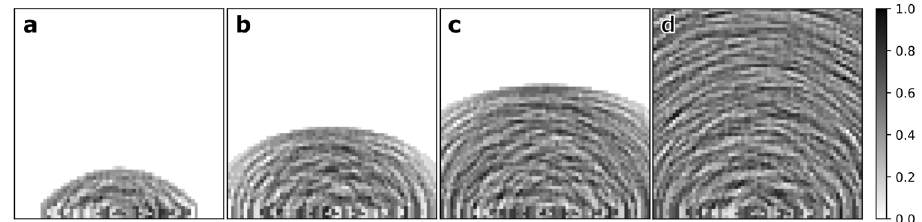
Fig. 2 Time-of- fl ight sampling mask. Panels a , b , c , and d show the normalized spatiotemporal mask at different times ( t a < t b < t c < t d ). This mask is generated by 12 transmitters arranged in a line with the receiver in the center. Notice the several elliptical contributions adding to unique spatial patterns at each